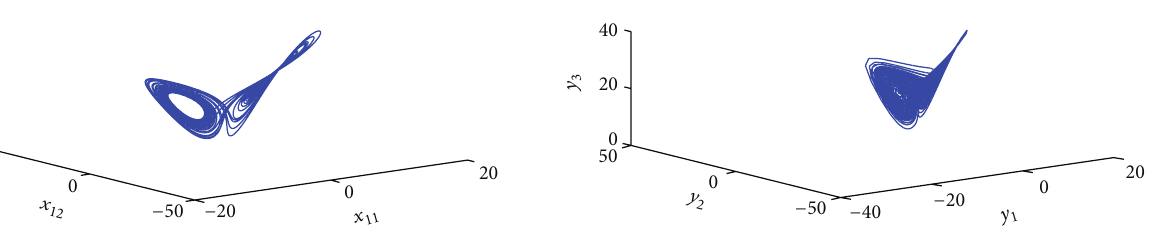
Figure 3: Chaotic attractors of fractional-order Chen system (27) for 𝑞 𝑟 = 0.85